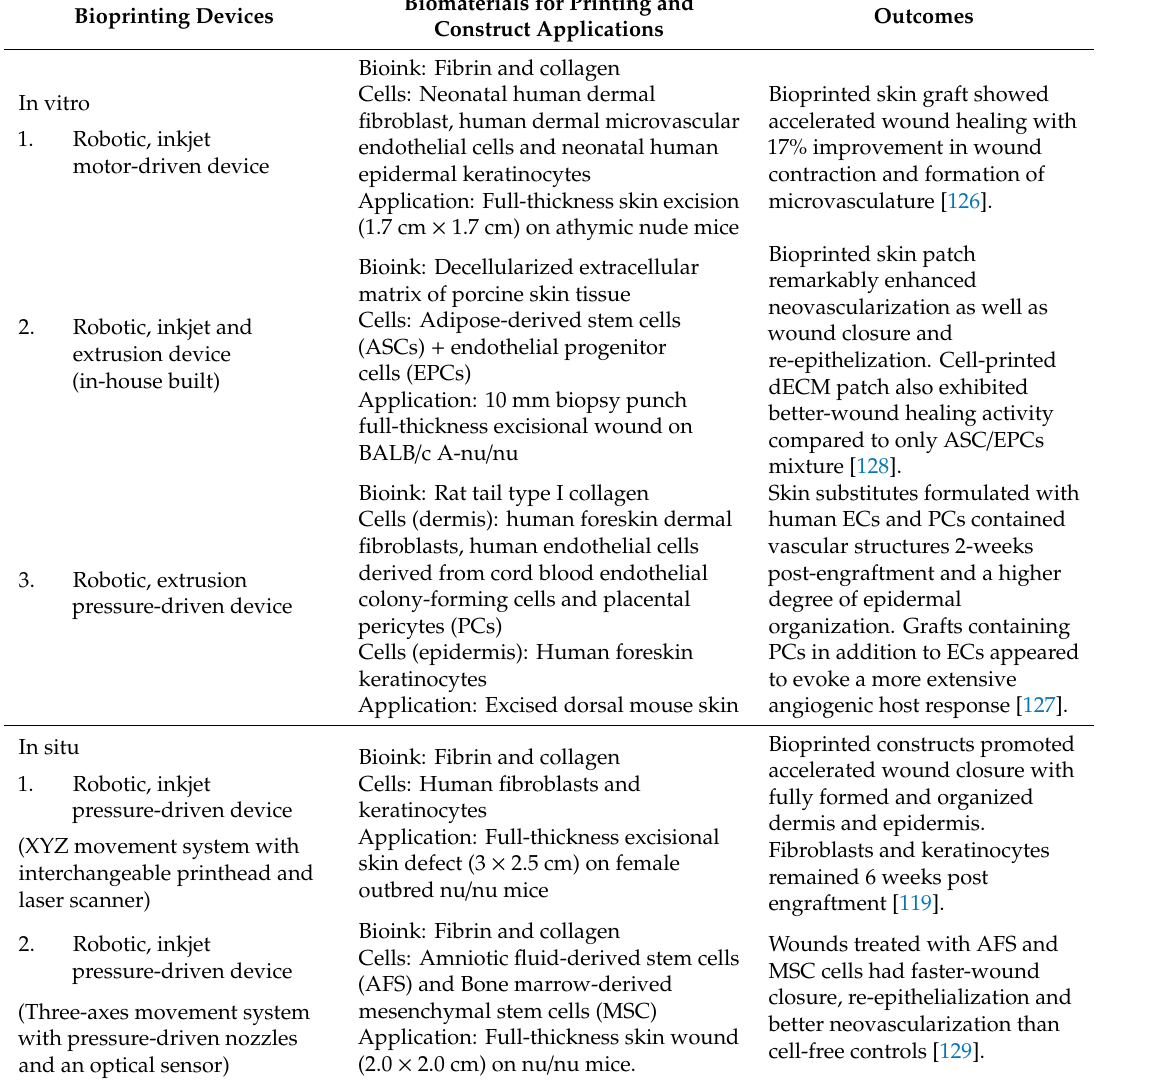
Table 2. Summary of 3D bioprinting approaches to aid in wound